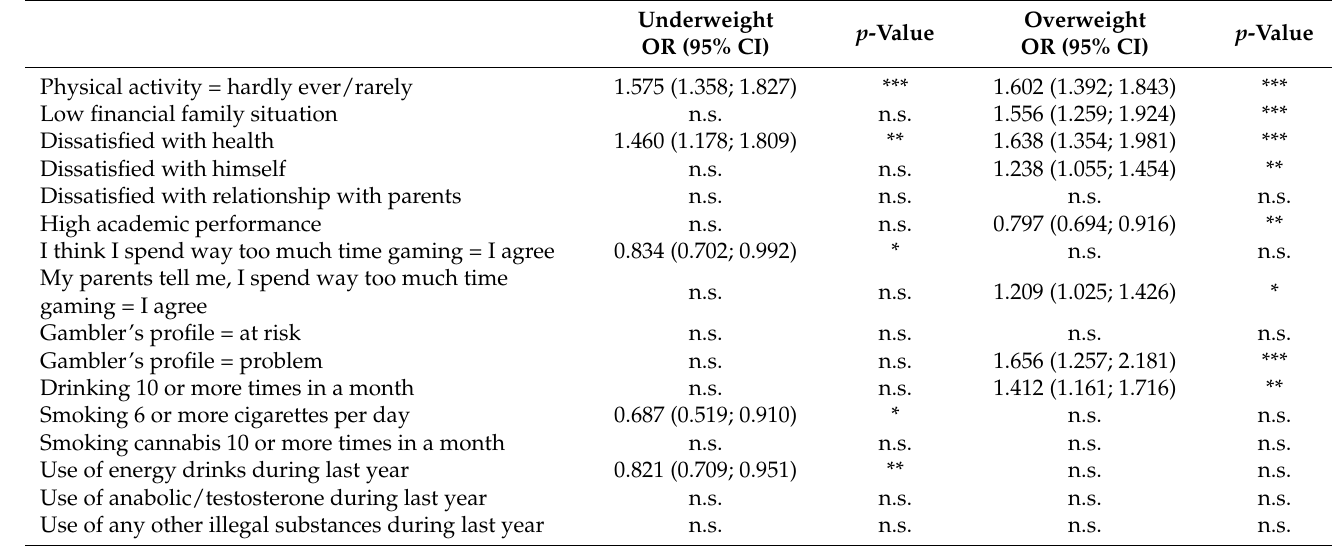
Table 2. Univariate logistic regression analysis between several risk factors and BMI condition: underweight and overweight vs. normal weight adolescents.